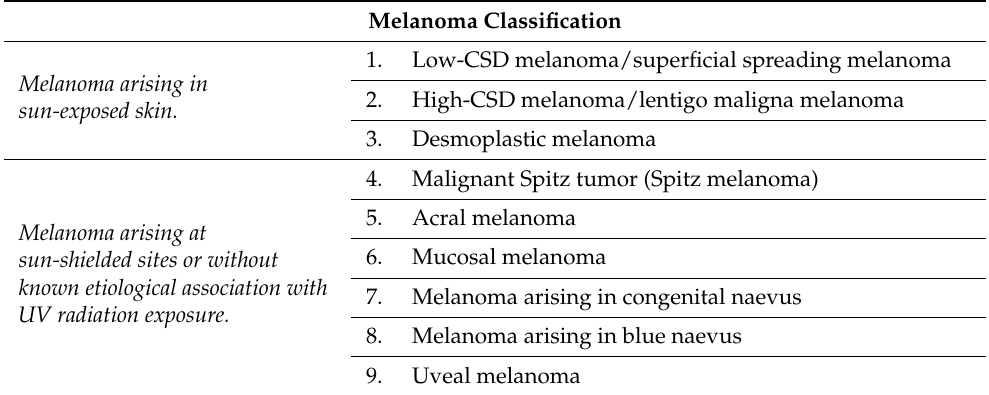
Table 1. Melanoma classification according to the associate cumulative sun damage (CSD) that relates with lesion’s molecular alterations. See explanation in the text. Adapted from reference [59] with